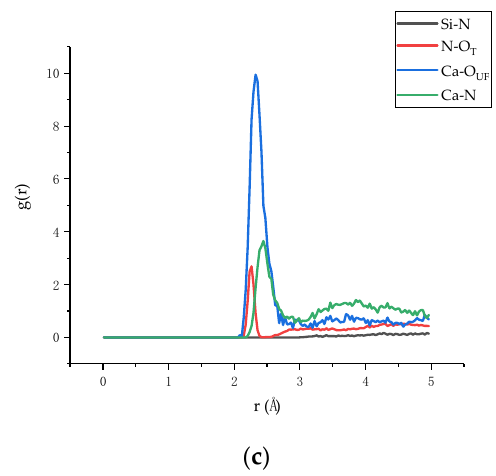
Figure 5. Radial distribution function (RDF): ( a ) RDF of T9-UF, ( b ) RDF of T11-UF, ( c ) RDF of T14-UF (The O T and O UF stand for the oxygen in Tobermorite and UF, respectively).